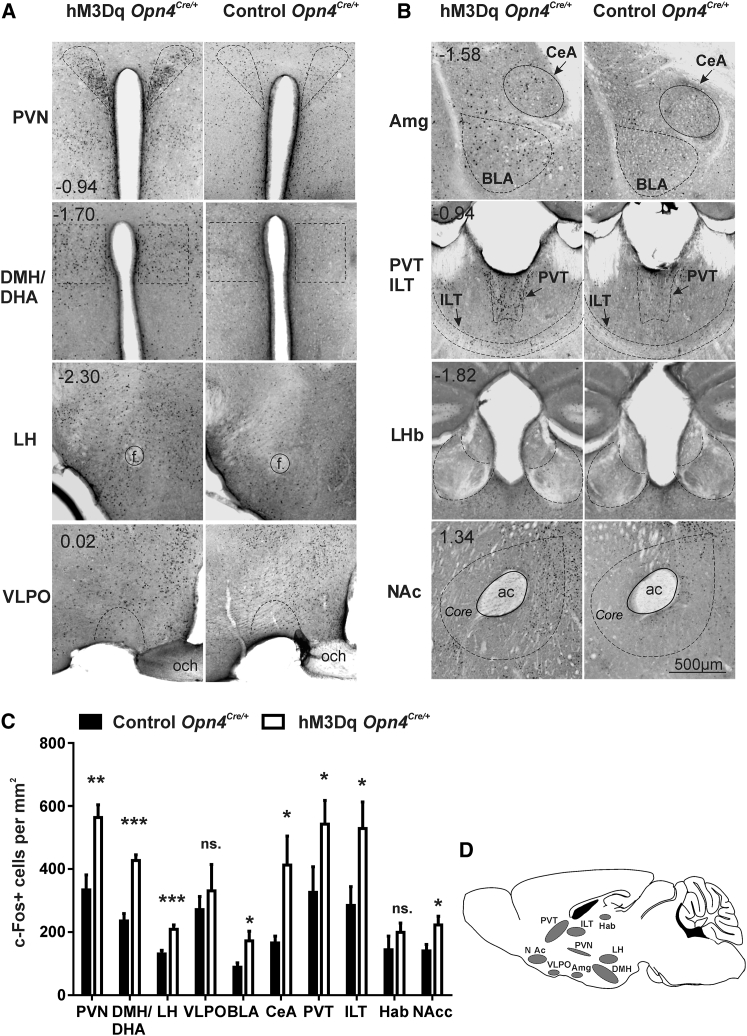
c-Fos Activity Mapping after Chemogenetic Activation of mRGCs(A and B) Representative micrographs of coronal sections showing c-Fos labeling (dark) in (A) the paraventrical hypothalamic nucleus (PVN), the dorsomedial hypothalamus/dorsal hypothalamic area (DMH/DHA), lateral (perifornical) hypothalamic area (LH), and ventrolateral preoptic nucleus (VLPO); and (B) amygdala (Amg), intralaminar thalamic nuclei (ITL), paraventricular thalamus (PVT), lateral habenula (LHb), and nucleus accumbens (NAc). Images to right of each panel are from control mice, and those to left are from unilateral hM3Dq-expressing animals (transduced eye to right of presented image, except in LH, VLPO, Amg, and NAc, where only the contralateral region is shown).(C) Mean (±SEM) number of c-Fos-positive cells mm−2 in all brain regions (bilaterally) after CNO administration (5 mg/kg, i.p., at CT14) in hM3Dq-expressing (open bars; n = 8) and control (filled bars; n = 8) mice (two-tailed unpaired t test, ∗p < 0.05, ∗∗p < 0.01, ∗∗∗p < 0.001). A complete summary of c-Fos data is provided in Table S1. BLA, basolateral amygdala; CeA, central nucleus of the amygdala.(D) Brain diagram illustrating target areas analyzed.